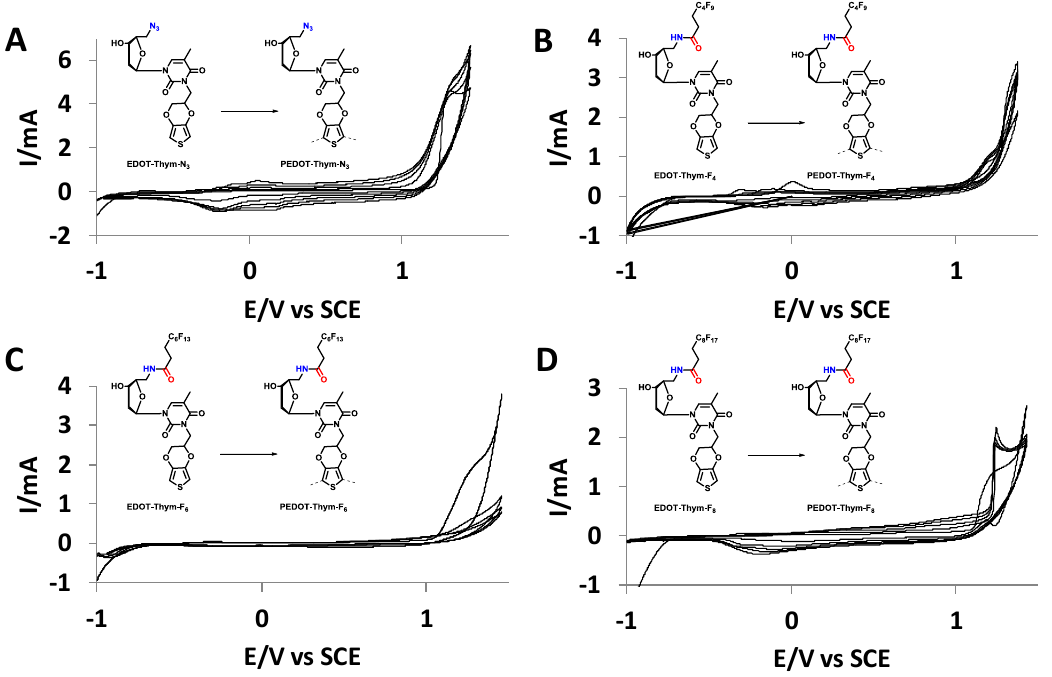
Figure 2. Examples of voltammogram. ( A ) EDOT-Thym-N 3 to PEDOT-Thym-N 3 ; ( B ) EDOT-Thym-F 4 to PEDOT-Thym-F 4 ; ( C ) EDOT-Thym-F 6 to PEDOT-Thym-F 6 ; ( D ) EDOT-Thym-F 8 to PEDOT-Thym-F 8 .